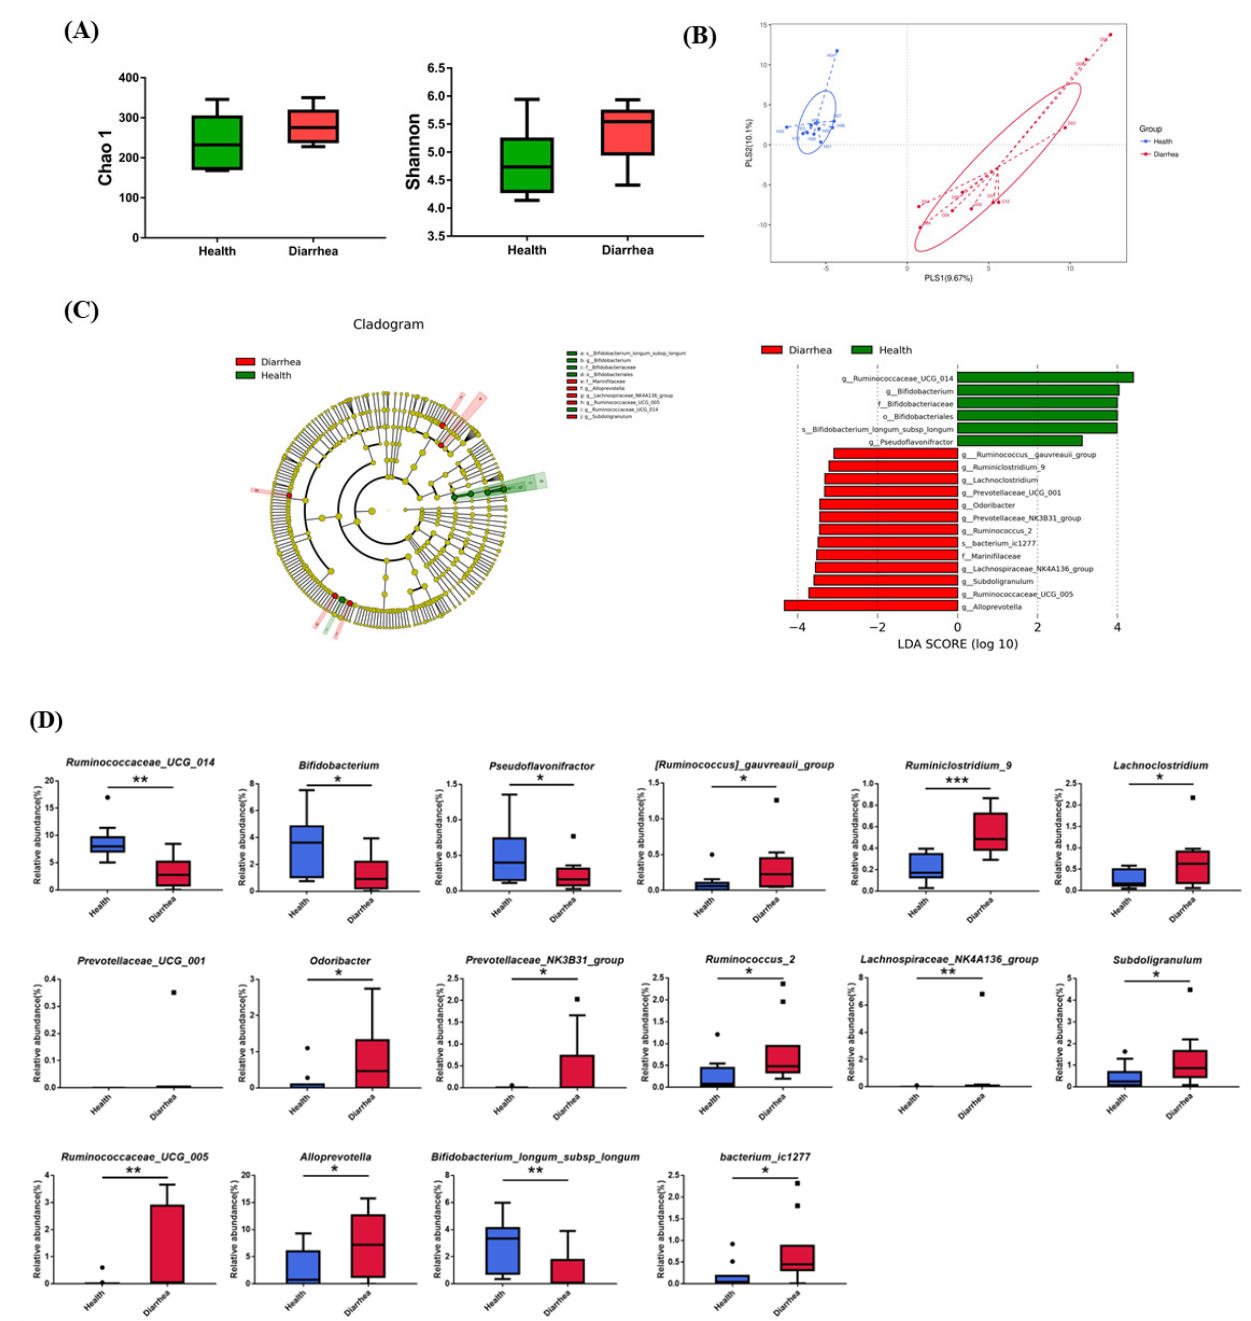
Figure 2. Microbiota analysis. ( A ) Bacterial community richness index estimated by the Chao1 value and community diversity index estimated by Shannon index between healthy and diarrheic calves. ( B ) Partial least squares discriminant analysis (PLS-DA) plots applied to maximally reflect the discrimination between healthy and diarrheic groups. ( C ) Taxonomic cladogram and histogram of the linear discriminant analysis (LDA) threshold value > 3.0 using LDA effect size analysis with the greatest differences in bacterial marker abundance between healthy and diarrheic calves. ( D ) Relative abundance of microbial markers at the genus and species levels of healthy ( n = 10) and group with diarrhea ( n = 10). Symbols indicate significant difference between two groups analyzed through Mann–Whitney U test. Significant difference: * p < 0.05, ** p < 0.01, *** p < 0.001.The dot represent the outlier value of